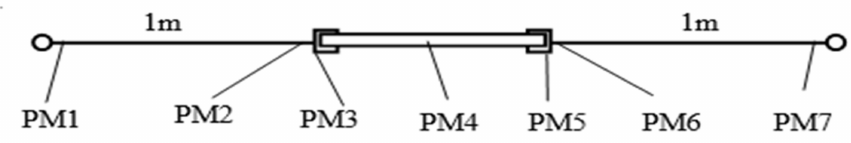
Figure 6. Arrangement of measuring